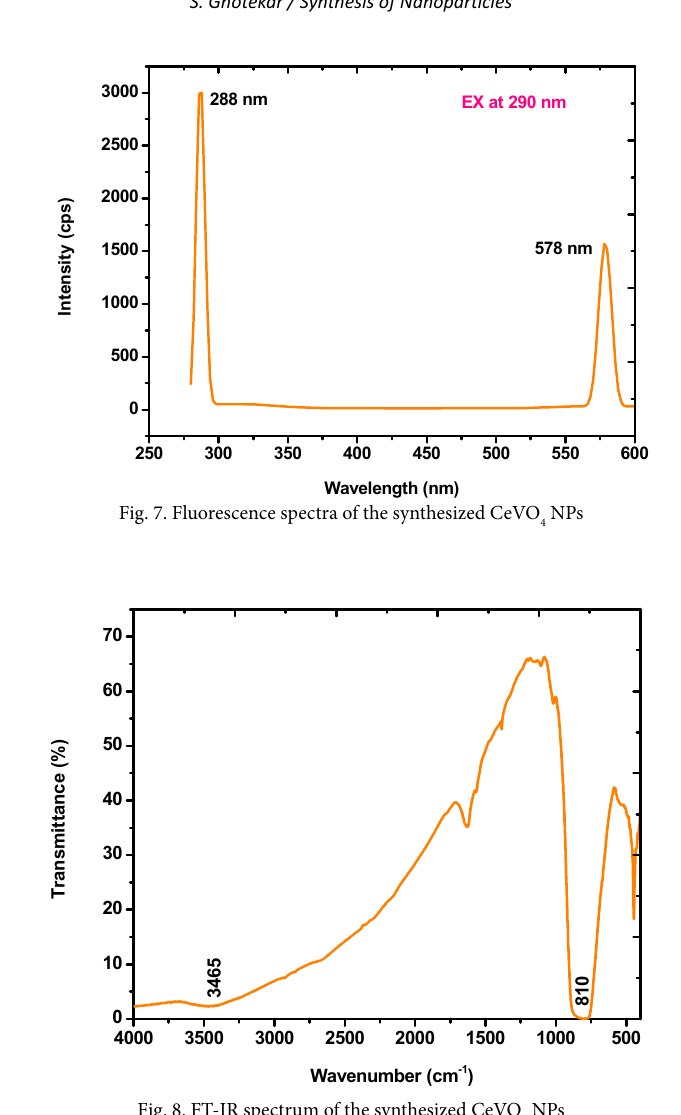
Fig. 8. FT-IR spectrum of the synthesized CeVO Fig. 8 FT-IR spectrum of the synthesized CeVO 4 NPs Table 1. Minimum inhibition concentration of CeVO